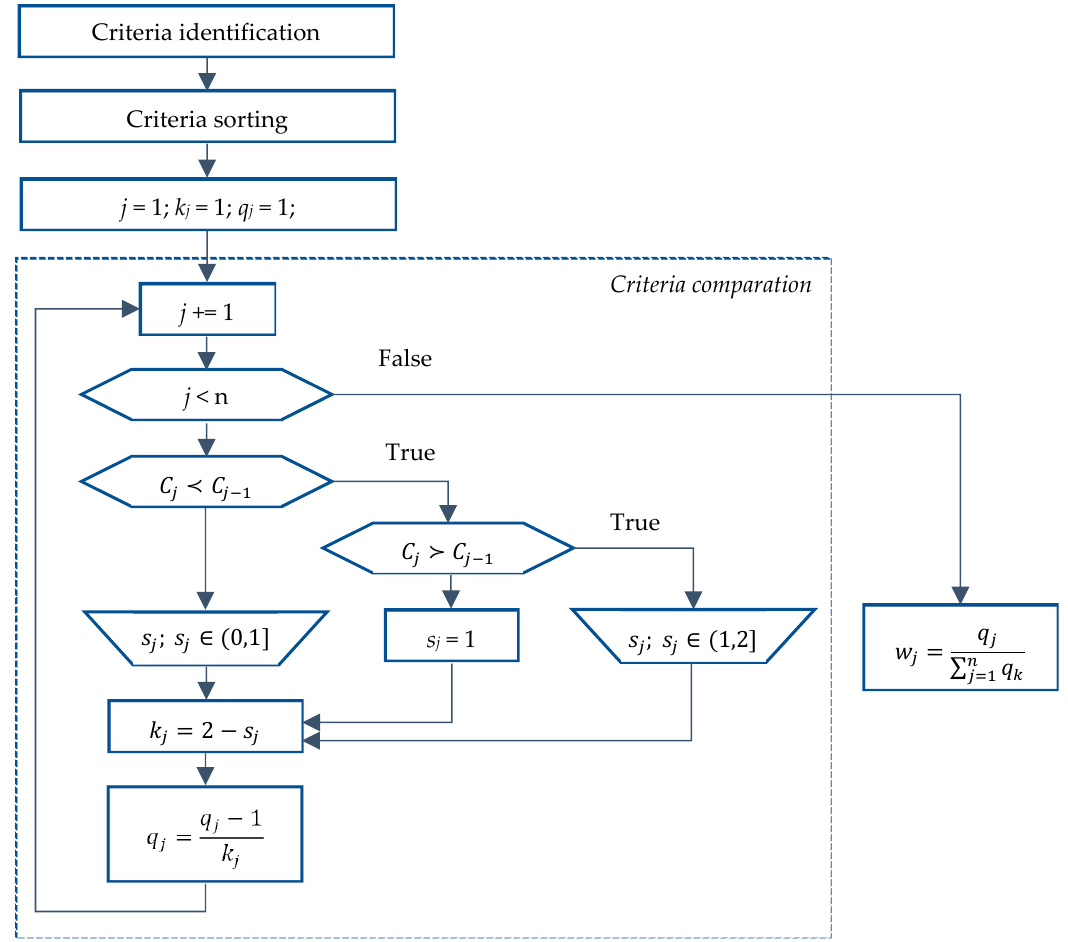
Figure 3. Flowchart of the PIPRECIA method.